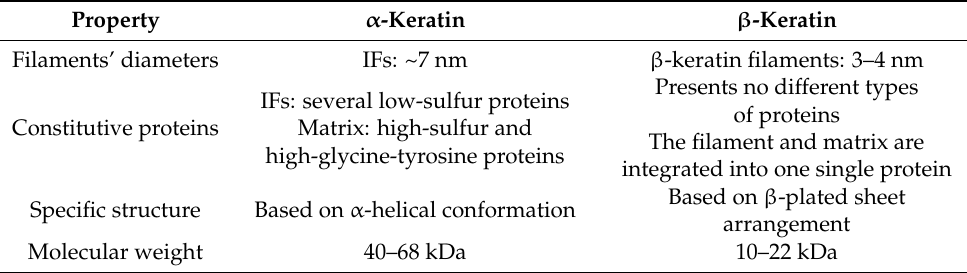
Table 1. Structure of α -keratin and β -keratin adapted from [7].